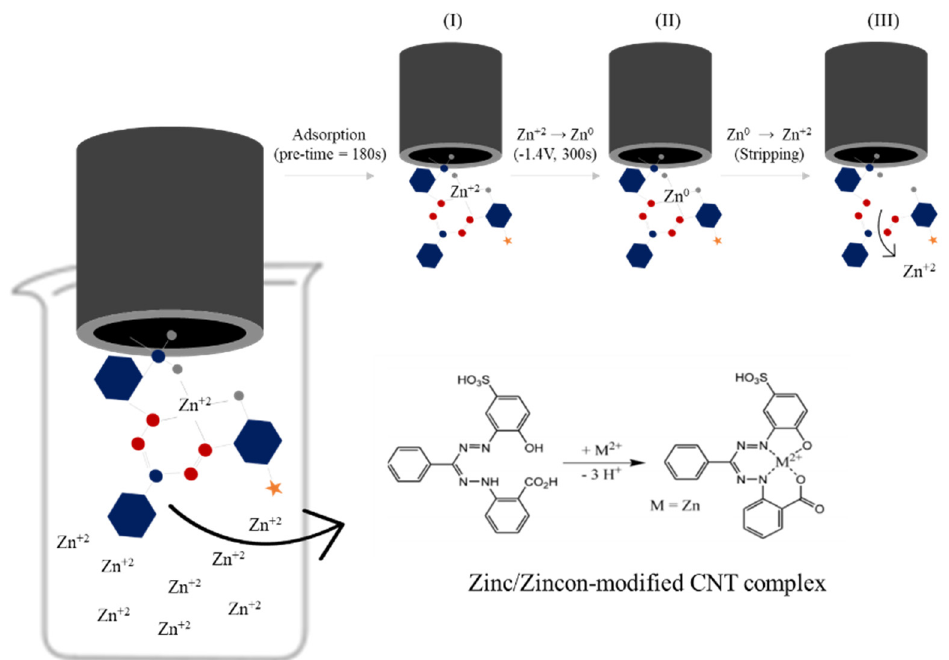
Figure 4. Schematic of complexation mechanism of zincon–modified CNT and Zn +2 ; (I) adsorption, (II) reduction and (III) stripping step. The hexagon, gray dots, blue dots, red dots, and star represent aromatic group, oxygen element, carbon element, nitrogen element and Sulfonic acid, respectively.